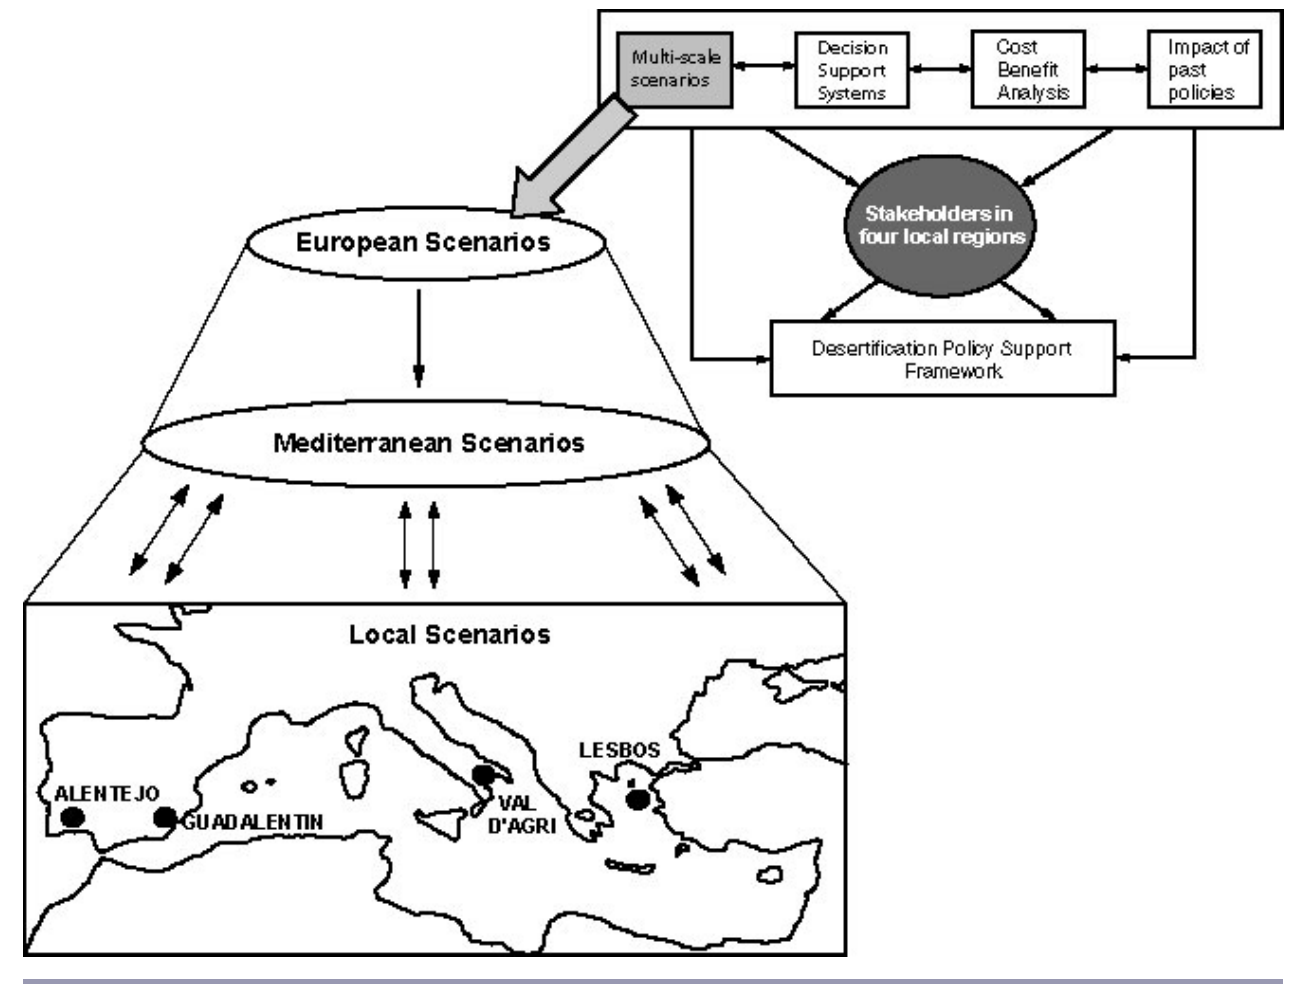
Fig. 1 . Simplified Program Evaluation and Review Technique (PERT) diagram of the main activities in MedAction (upper right) and scales for which multiscale scenarios were developed (lower